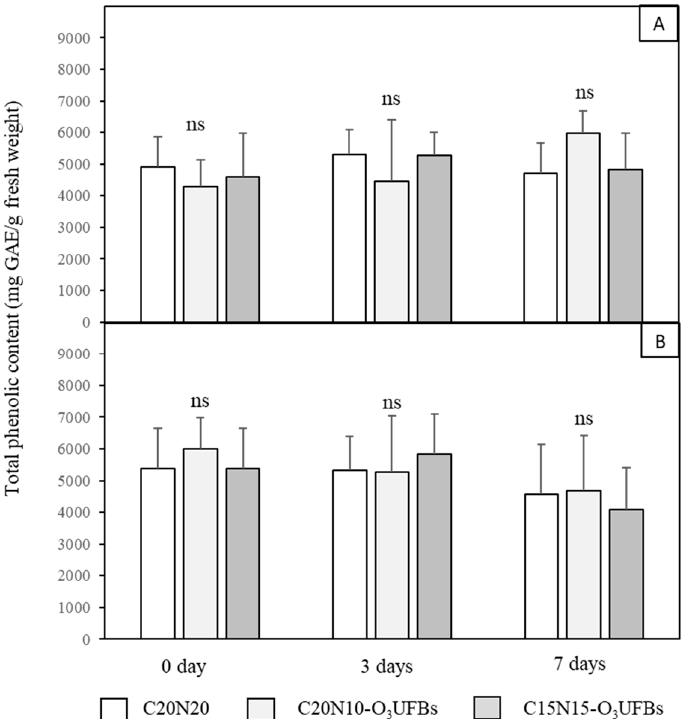
Figure 9. Total phenolic content of coconut mesocarp of trimmed coconuts dipped in C 20 N 10 -O 3 UFBs and C 15 N 15 -O 3 UFBs compared with C 20 N 20 when stored at 2 °C for 0 days (before storage) ( A ) and 30 days ( B ). After storage, all coconut fruits were transferred to 8–10 °C for 7 days and total phenolic content was evaluated on days 0, 3, and 7. ns: not significantly different.